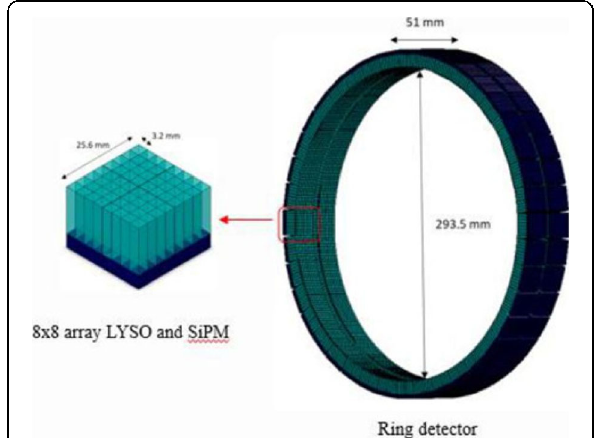
Fig. 2 (abstract A25). Geometry of brain PET for